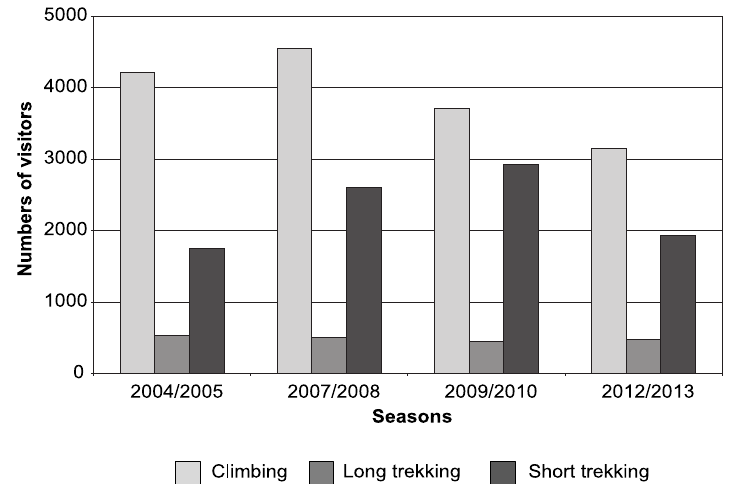
Fig. 8. Mountaineering activity in scope of climbing, short and long